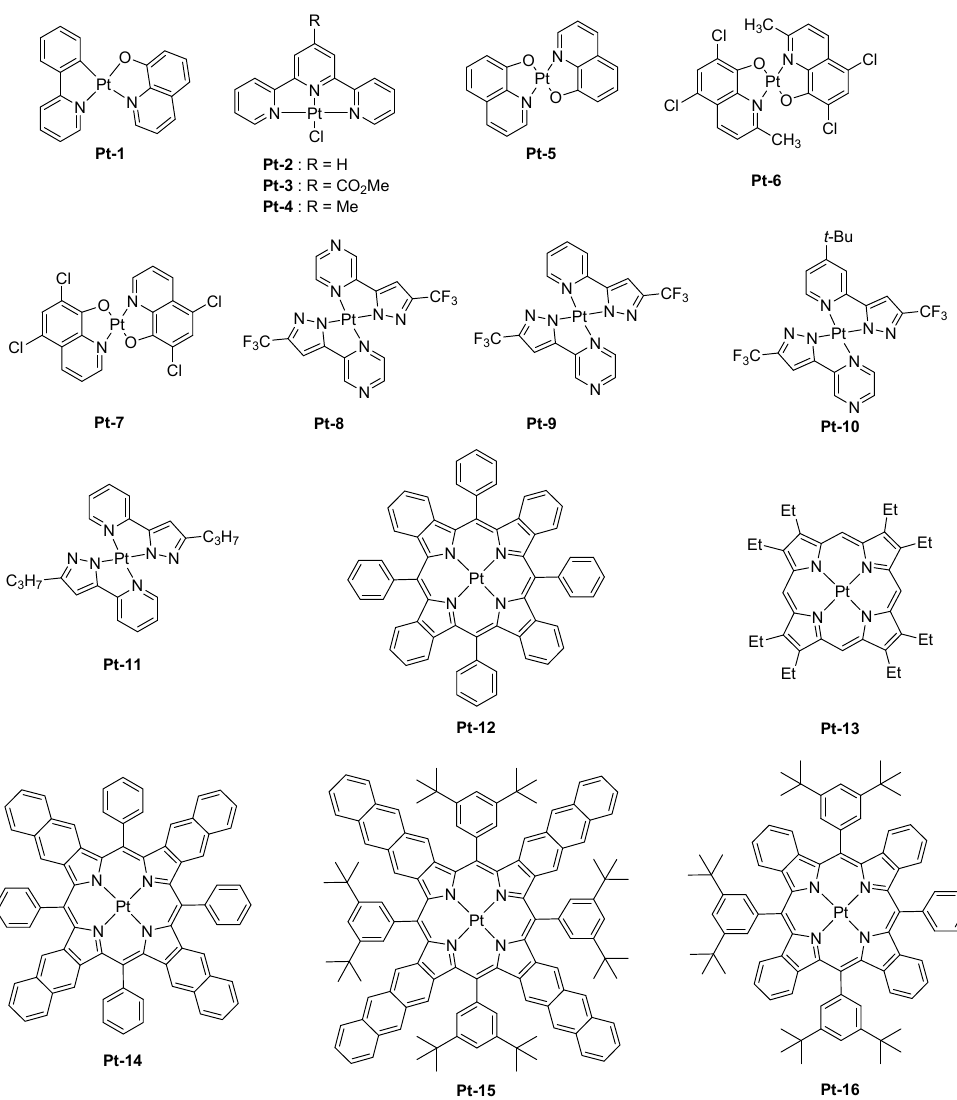
Figure 1. Pt-based near-infrared (NIR) emitters for light-emitting diodes.